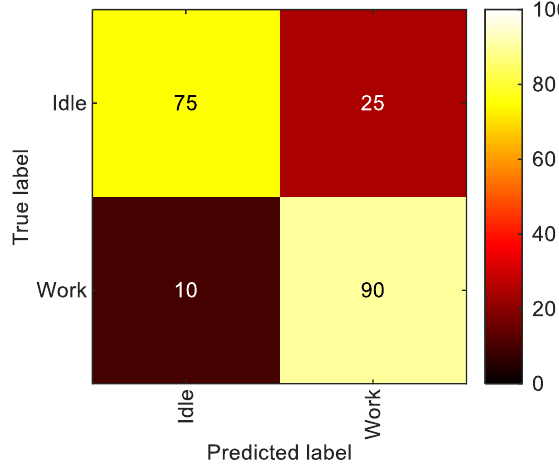
Figure 6. LoD1 confusion matrix for the DeepConvBiLSTM .